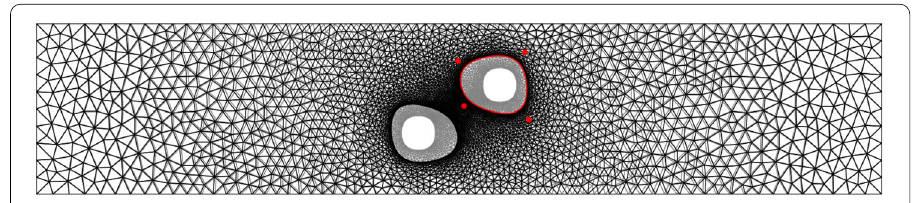
Fig. 10 Improved geometry (in black) compared to the initial geometry (in grey), and 1D-FFD morphing box and its control points position at the end of the first optimization (in red)